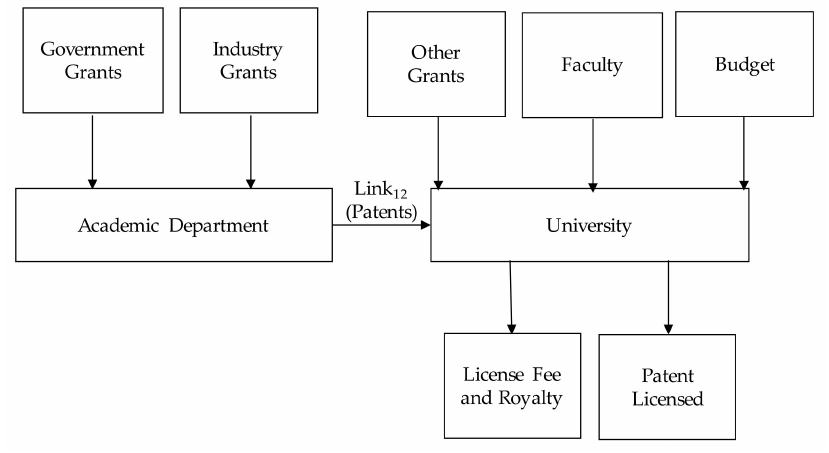
Figure 5. Structure Model. Table 6. Input, output, and link variables of IAC.